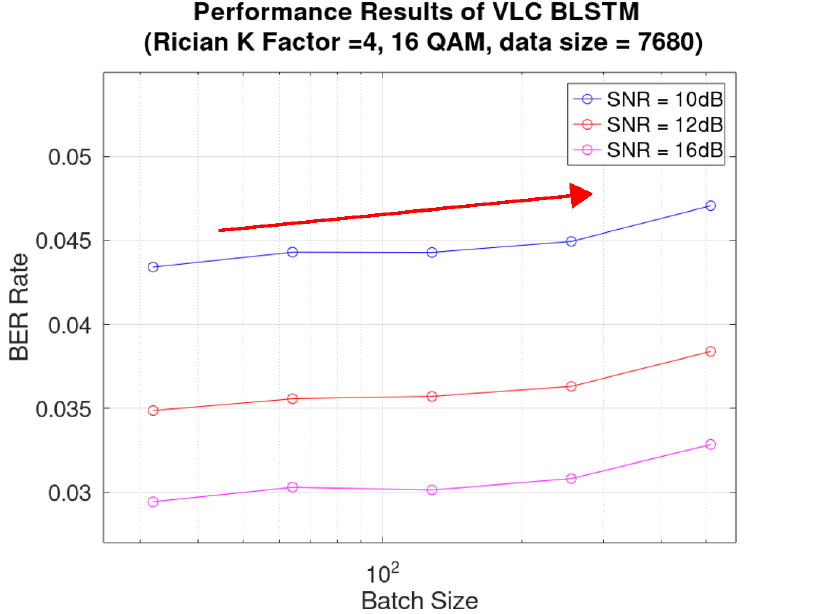
Figure 15. BER performances of batch sizes over SNR with Rician fading K factor = 4, 16